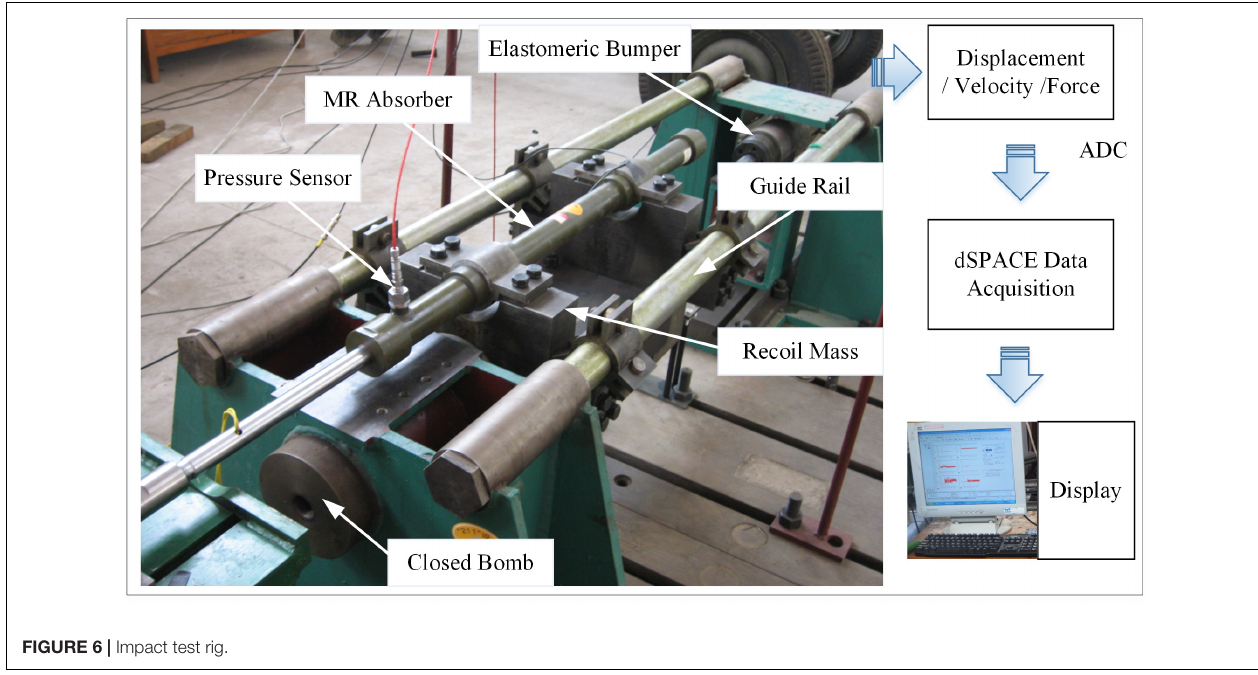
FIGURE 6 | Impact test rig.